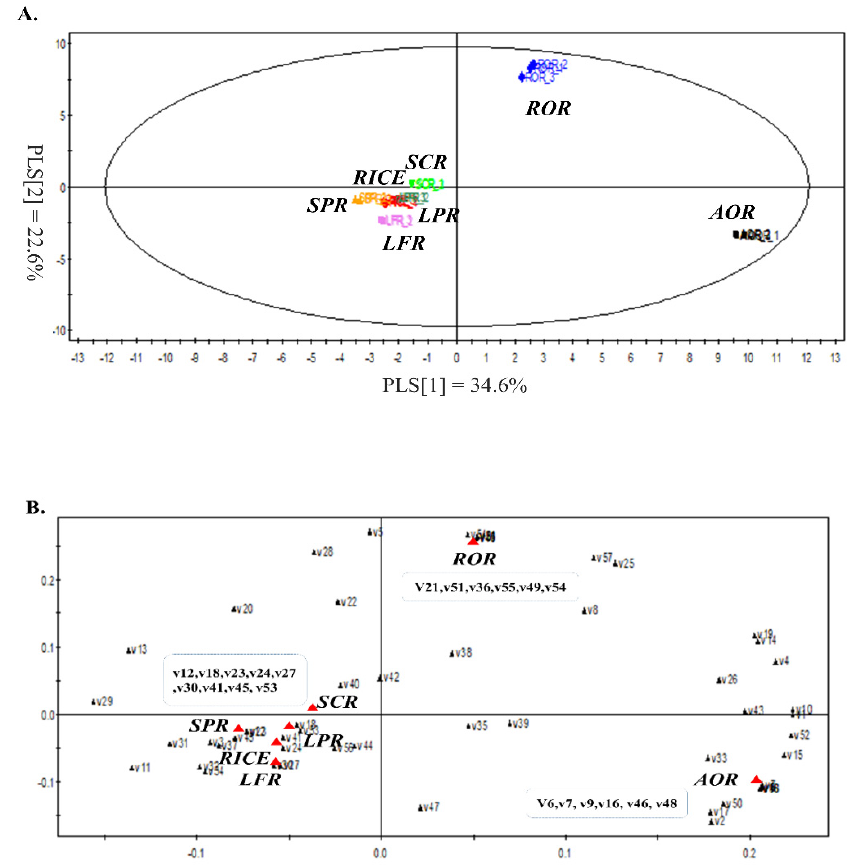
Figure 1. Partial least squares-discriminant analysis (PLS-DA) score plot for volatile compounds profiles in fermented rice inoculated by different microbes. ( A ) Score plot, ( B ) loading plot. AOR = Aspergillus oryzae , ROR = Rhyzopus oryzae , SCR = Sacharomyces cerevisiae , SFR = Saccharomycopsis fibuligera , LFR = Lactobacillus fermentum , LPR = Lactobacillus plantarum , RICE = controls (non-fermented rice).